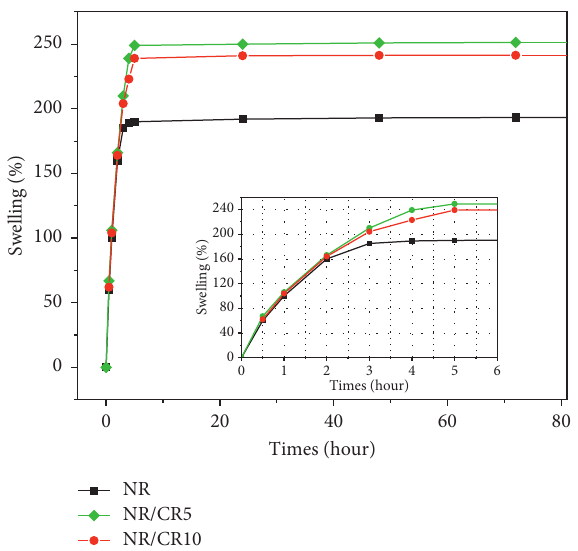
Figure 1: Swelling behaviour of NR and NR/CR blends. Table 2: “Apparent” network density of NR and NR/CR blends.